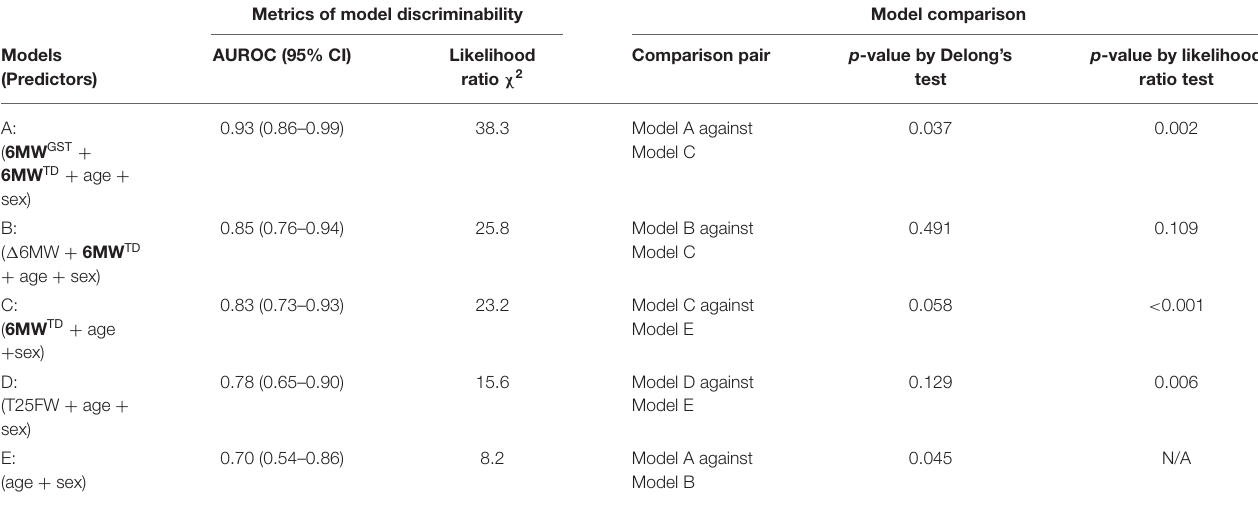
TABLE 3 | Discriminative information comparison using logistic regression models with MS status as the